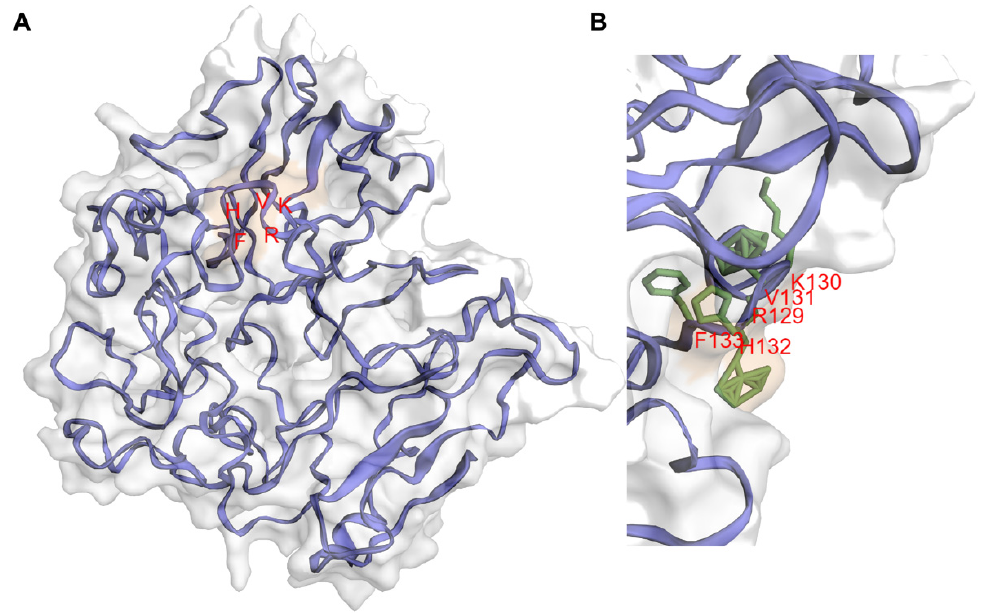
Figure 1. Molecular dynamics-refined model structure of human PPP1R32. ( A ) Cartoon representation of the best human PPP1R32 model according to the Z-score assessed by the ProSA webserver after 700 nanoseconds of molecular dynamics simulations. Protein structure, side chains, and surface patches were rendered with the EzMol server [18,19] . The model can reach a globular stable structure after 400 nanoseconds of molecular dynamics simulations. In the PPP1R32 protein model, the RKVHF motif (depicted with red letters) is accessible to the solvent. ( B ) Snapshot of RKVHF motif, depicting a histidine residue fully accessible to the solvent.